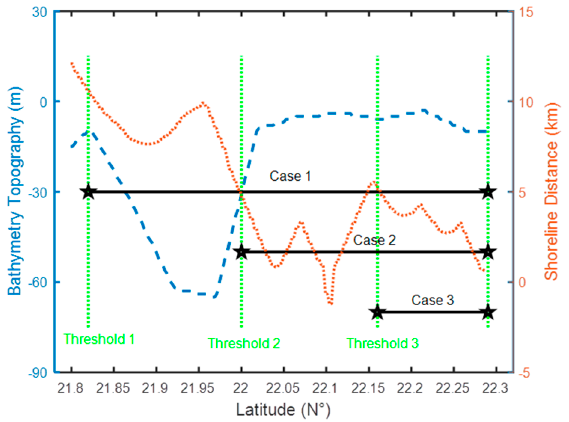
Figure 3. Bathymetry and shoreline distance at the Hong-Kong (HK) coast along 3 segments of the Jason-2 pass identified as cases 1, 2, and 3 (see location in Figure2).